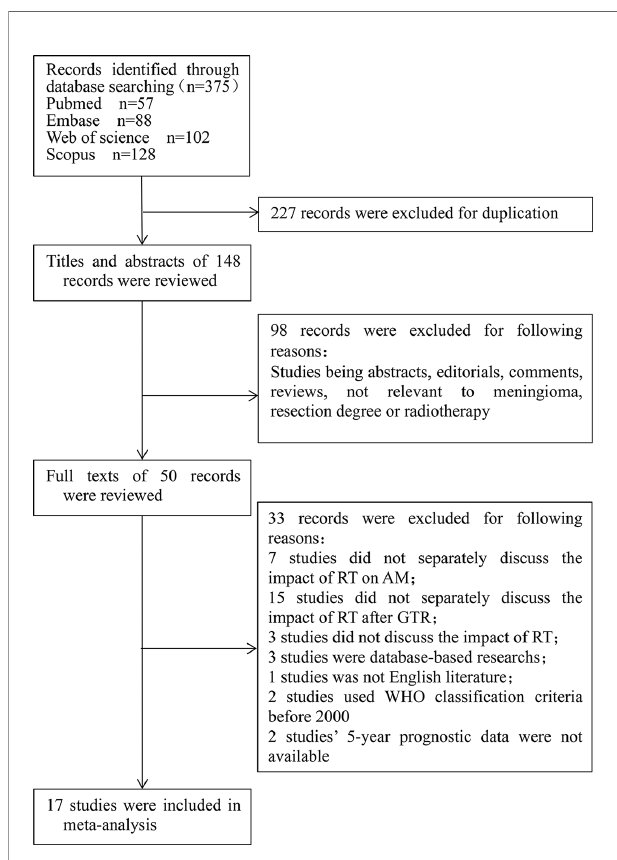
FIGURE 1 | Flow chart of study selection